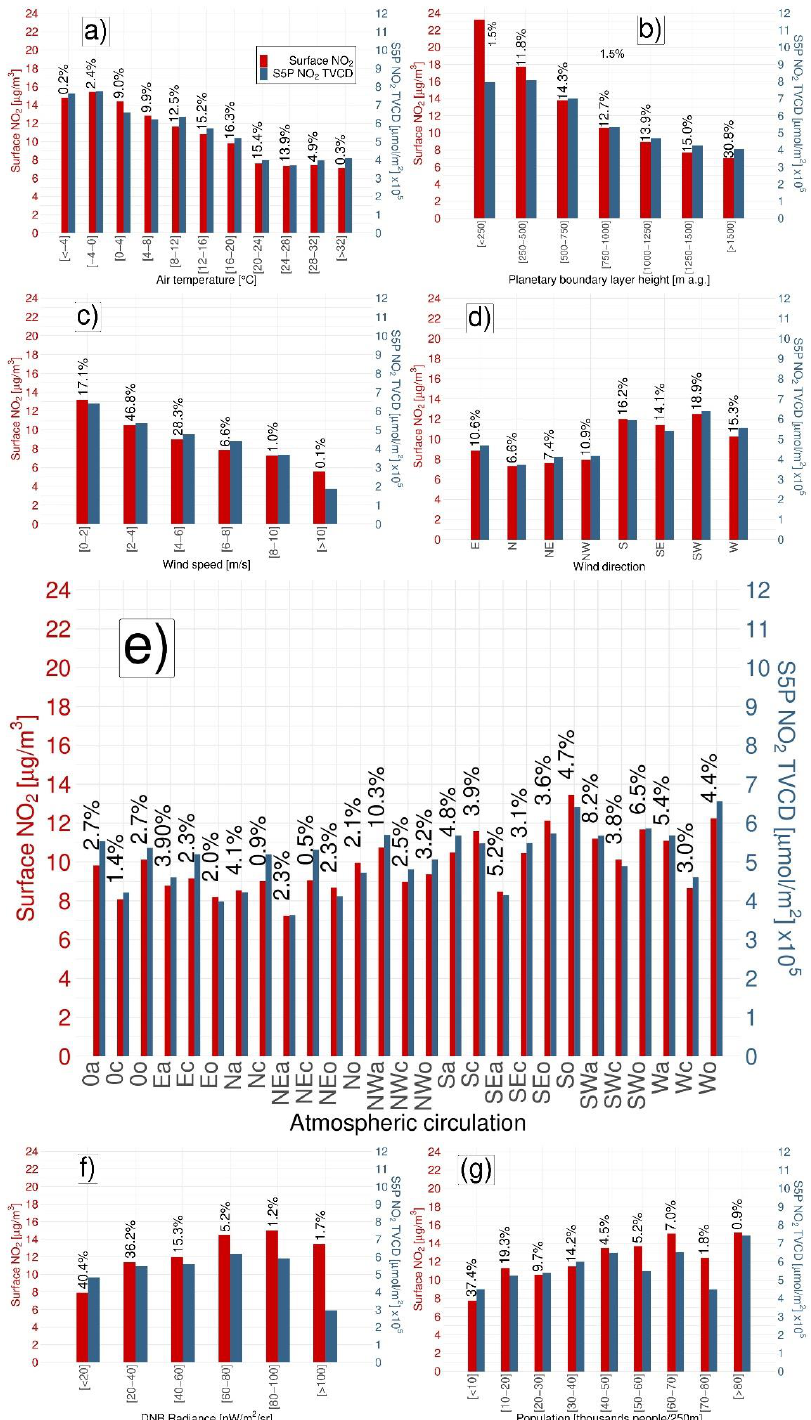
Figure 6. Changes in surface NO 2 mass concentration ( µ g/m 3 ) and TVCD (umol/m 2 ) × 10 5 of NO 2 due to meteorological conditions and anthropogenic factors. On the left y axis, the red font and red bars correspond to the surface NO 2 mass concentrations, while on the right y axis, the blue font and blue bars correspond to the TVCD of NO 2 . Every chart shows changes in air pollution with respect to different variables: ( a ) air temperature; ( b ) planetary boundary layer height; ( c ) wind speed; ( d ) wind direction; ( e ) atmospheric circulation; ( f ) nighttime radiance; ( g ) population. Note: % on the bars refers to the percentage of observations of the total